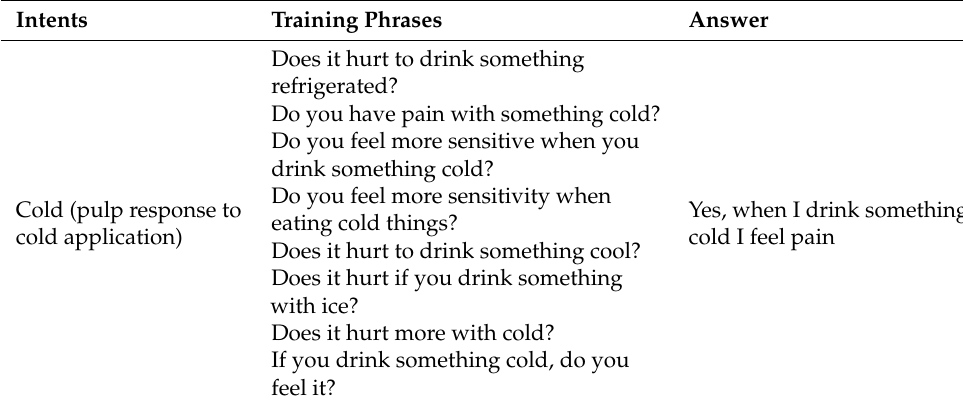
Table 2. Question-answer sequence of the